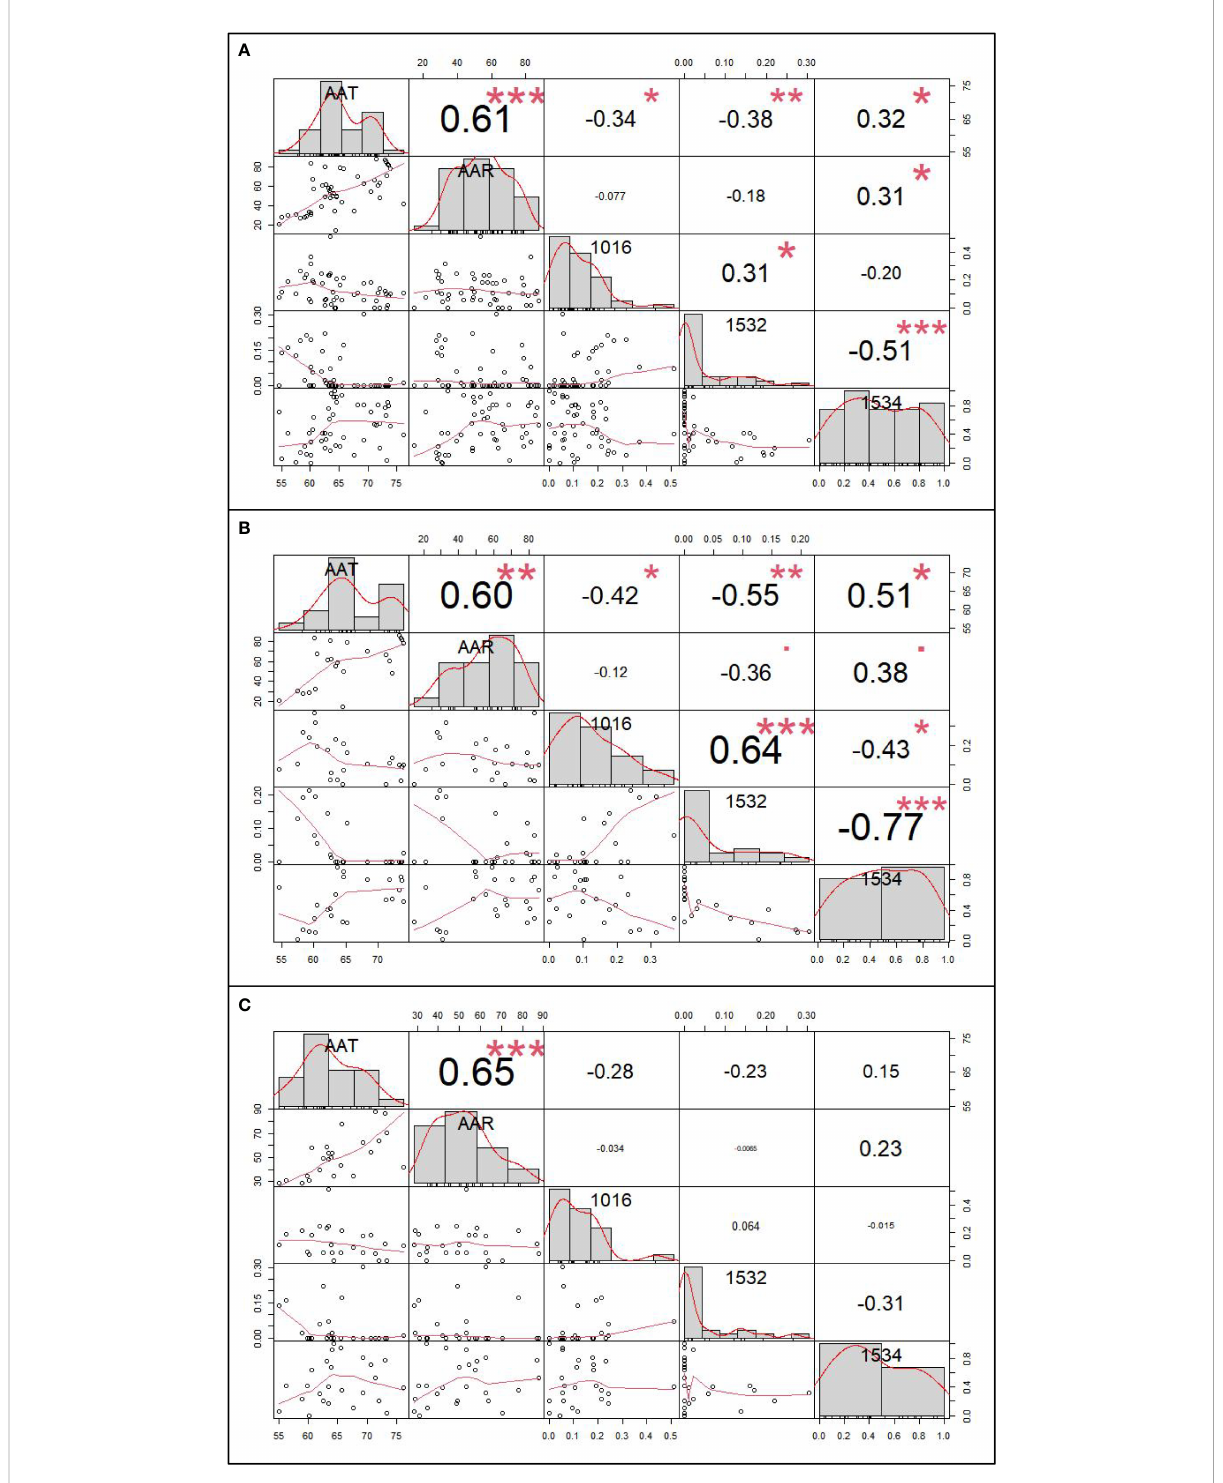
FIGURE 5 The correlation analysis result between kdr mutation rates and meteorological factor. (A) The correlation analysis result among 49 sample collection sites; (B) The correlation analysis among 24 sample collection sites of dengue epidemic areas; (C) The correlation analysis among 25 sample collection sites of non-dengue epidemic areas.* refer to P <0.05, ** refer to P <0.01, and *** refer to P